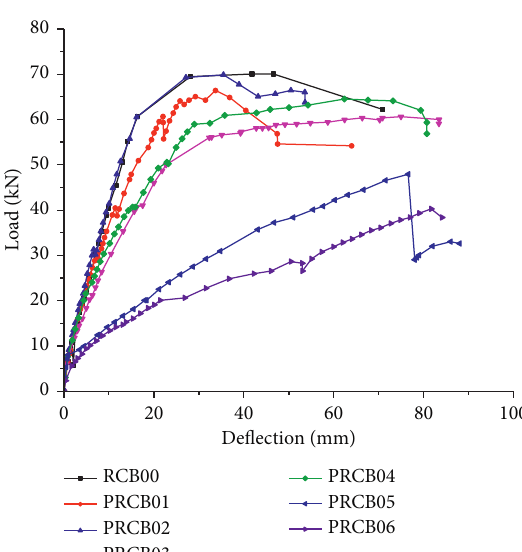
Figure 10: Load deflection